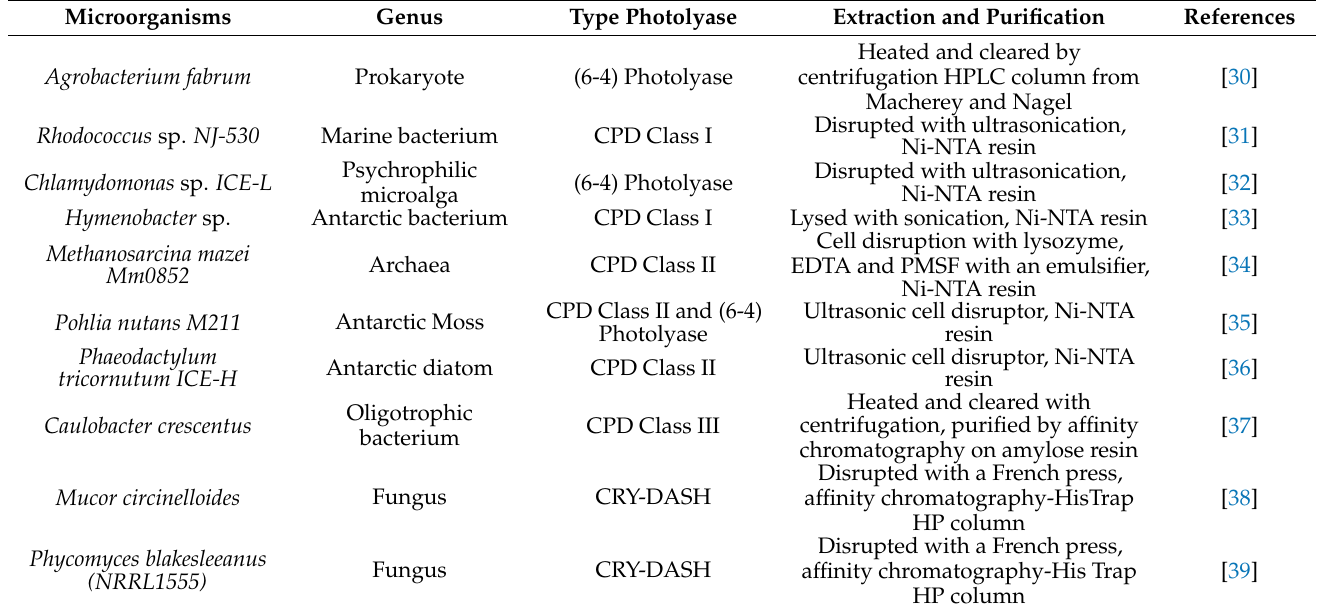
Table 1. Studies demonstrating the presence of different types of photolyases in various organisms and the extraction and purification methods necessary to prove their DNA repair activity.